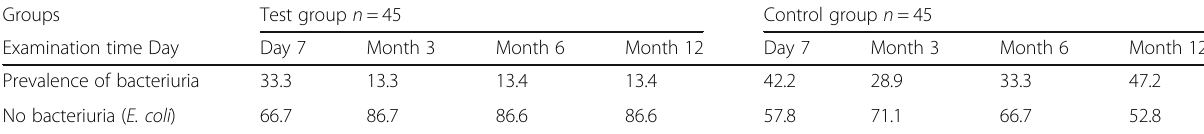
Table 3 Prevalence of bacteriuria and no bacteriuria ( E. coli titer > 10 3 CFU /ml) in the two treatment groups Groups